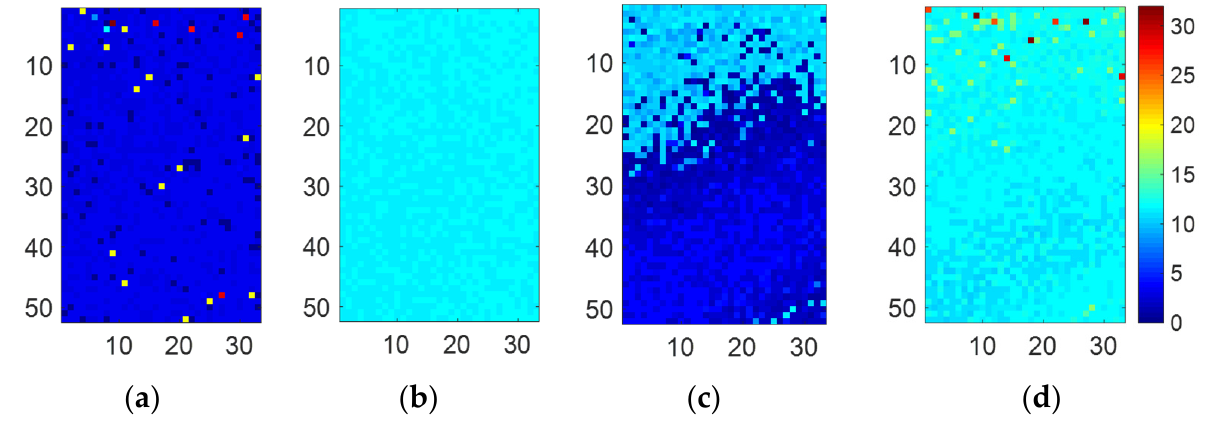
Figure 14. Measured depth images (33 × 52 pixels): ( a ) Acrylic plate placed at 1 m (single path). ( b ) Mirror placed at 9.3 m (single path). ( c ) Acrylic plate depth (dual-path). ( d ) Mirror depth (dual- path). In the dual-path situation ( c , d ), the depths are similar to those in the single-path situations ( a , b ). The total processing time for the dual-path scene was 74 min. The percentages of the processing time for the first stage (coarse depth estimation by TVAL3) and the second stage (depth refinement by fminsearchbnd) were 0.7% and 99.3%, respectively. Specifications of